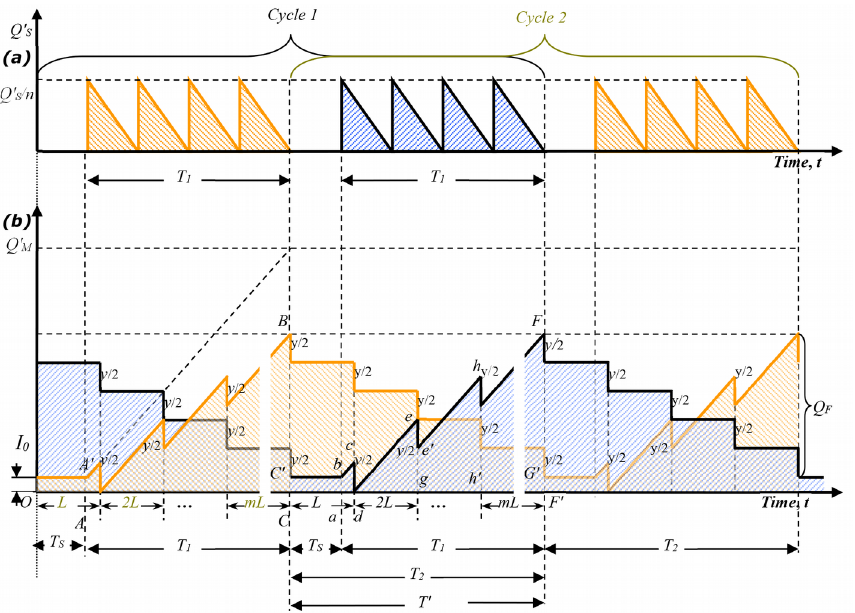
Figure 2. (a) Raw material inventory; (b) Finished goods